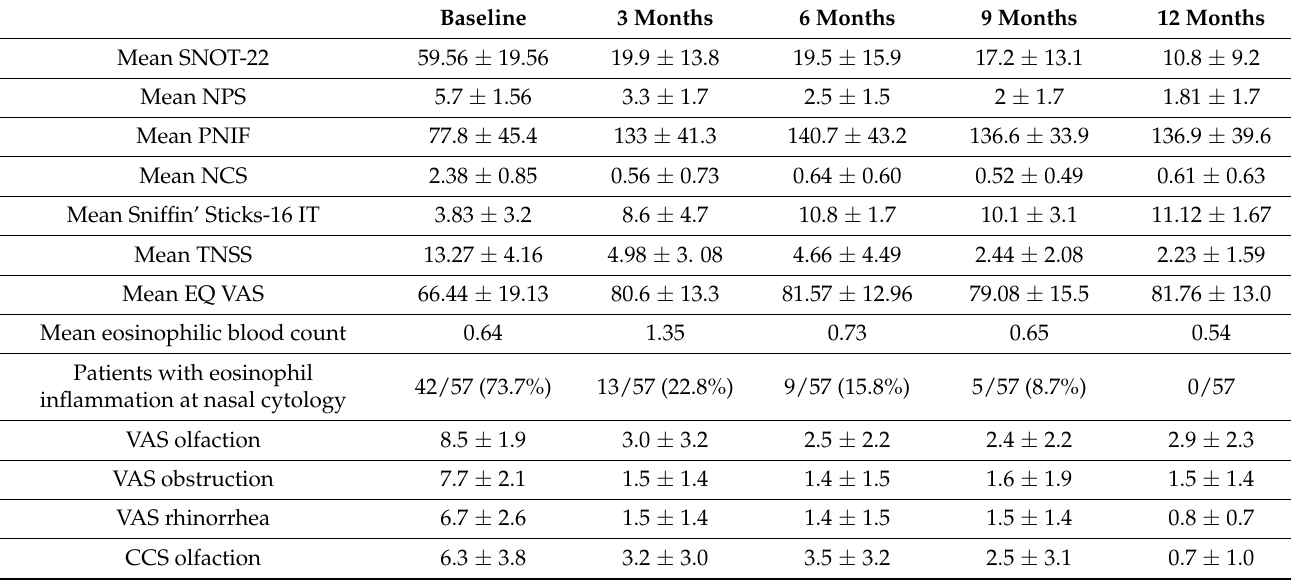
Table 3. Clinical outcomes during treatment.